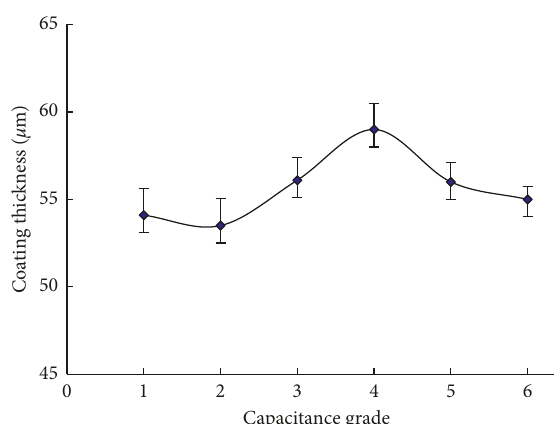
Figure 8: Effect of capacitance on the coating thickness (the pipe diameter of the electrode is Φ 2.0, and the deposition time is 15min).